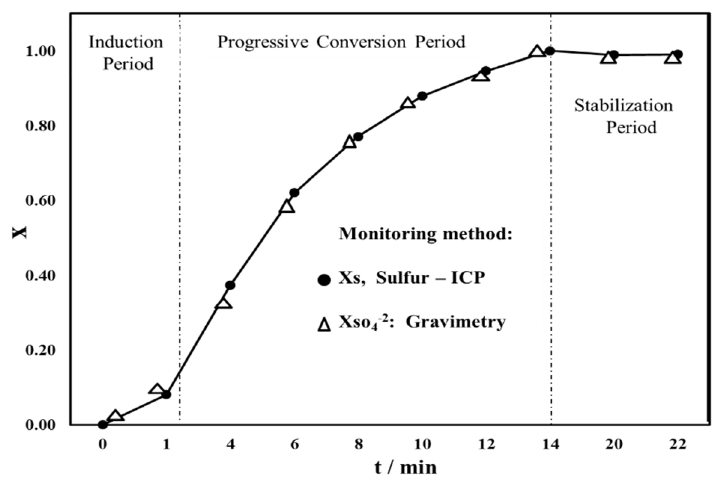
Figure 6. Decomposition curve of ammonium-sodium jarosite with arsenic in NaOH media (pH = 12.85, 303 K (30 °C), d 0 = 38 µm, RPM = 500 min − 1 ).